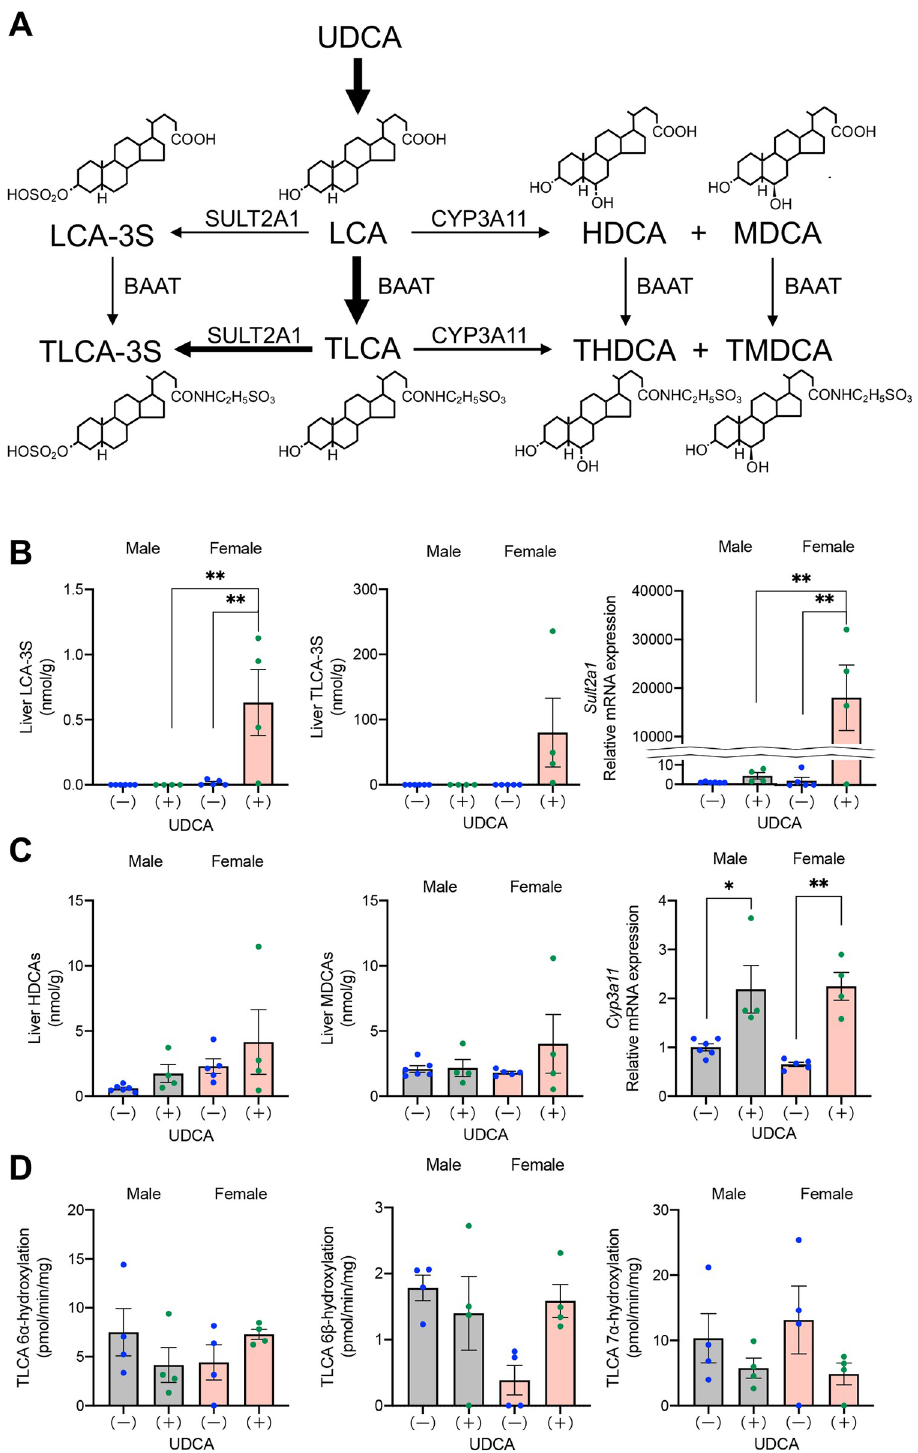
Fig 5. Comparison of LCA detoxification activities. DKO mice at 20 weeks of age, with (+) or without (-) UDCA treatment, were compared. (A) Proposed metabolic pathways for LCA in mice. (B) Hepatic concentrations of LCA-3S and TLCA-3S and mRNA expression levels of Sult2a1 . (C) Hepatic concentrations of HDCAs (HDCA + THDCA) and MDCAs (MDCA + TMDCA) and mRNA expression levels of Cyp3a11 . (D) Hepatic microsomal enzyme activities that catalyze 6 α -, 6 β -, and 7 α -hydroxylations of TLCA. Each column and error bar represents the mean and SEM. � P < 0.05 and �� P < 0.01 were considered statistically significantly different by the Tukey-Kramer test. https://doi.org/10.1371/journal.pone.0271308.g005 PLOS ONE | https://doi.org/10.1371/journal.pone.0271308 July 12,